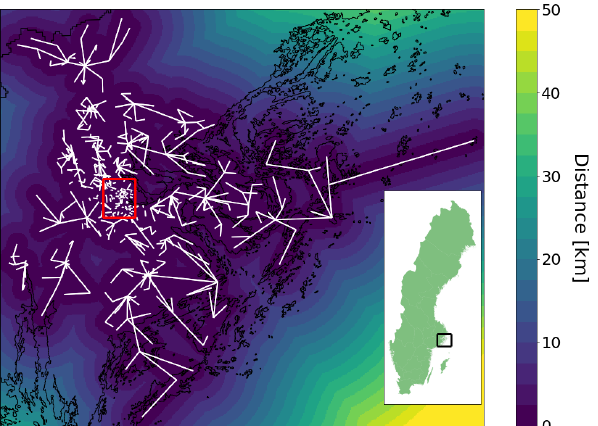
Figure 2. Distribution of microwave links in Hi3G’s Stockholm network. Here the white lines represent the links and the black lines the coast of Sweden around Stockholm. The colors in the legend represent the distance (km) per grid point to the closest link. The red square shows the selected sub-region at the city center. The inset shows the selected region within Sweden as a black